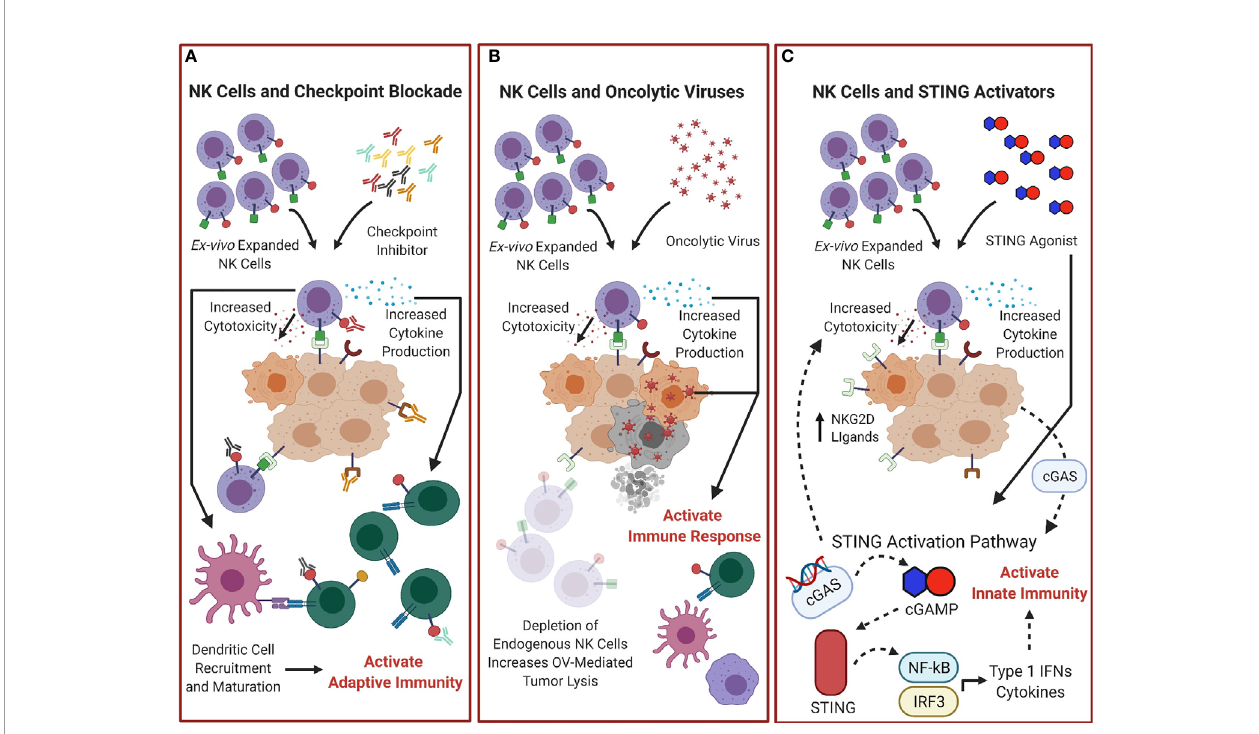
FIGURE 3 | Combination treatments of adoptive NK cells with other Immunotherapies could improve outcomes. (A) Adoptive transfer of NK cells combined with checkpoint inhibitor blockade could increase overall NK cytotoxicity and cytokine production and help control tumor and activate the adaptive immune response. (B) NK cell therapy combined with oncolytic virotherapy (OV) could improve therapeutic ef fi cacy. Depletion of endogenous NK cells would reduce the natural antiviral response and increase OV mediated tumor lysis, and adoptive transfer of NK cells would increase NK cell effector functions and enhance the antitumor response. (C) STING-dependent tumor rejection activated by cGAS expression from tumor cells (107) can be enhanced by combination therapy of STING agonists with NK cells. This would provide enhanced tumor lysis through further activation of the STING pathway, not only activating the innate immunity by stimulating expression of cytokines and Type I IFNs, but by increasing the presence of NK cell activating receptors ligands, which could enhance adoptive NK cell therapy antitumor